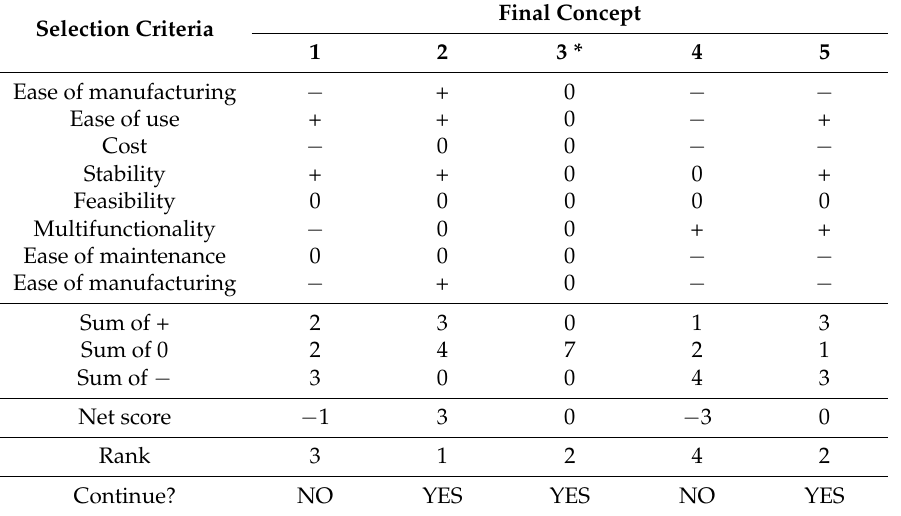
Table 13. Screening of final concepts.